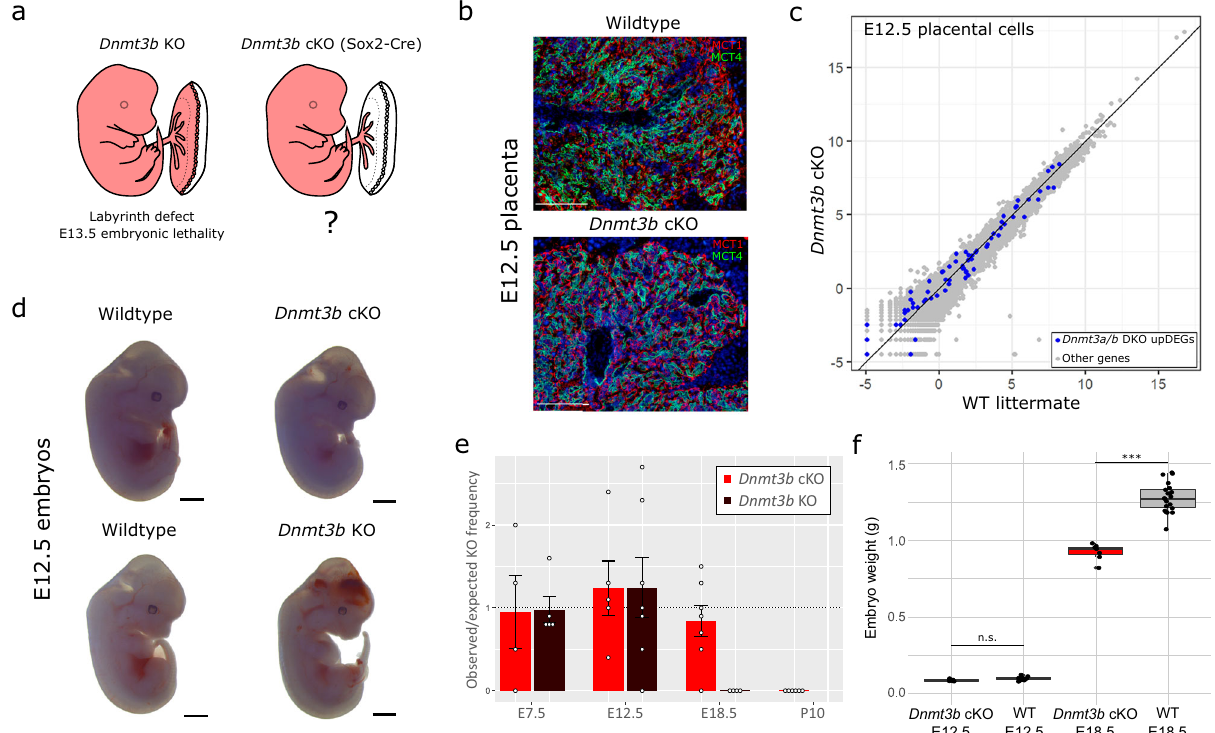
Fig. 5 | Dnmt3b cKOs show rescued placental labyrinth phenotype and conse- quently survive to birth. a The schematic diagram shows the lineages con- taining Dnmt3b deletioninthe Dnmt3b KOcomparedtothe Dnmt3b cKO,using Sox2-Cre. This schematic is adapted from Perez-Garcia, V. et al . Placentation defects are highly prevalent in embryonic lethal mouse mutants. Nature 555, 463-468 (2018). b Immuno fl uorescencefor MCT1(SynTI) and MCT4(SynTII)in E12.5placentasfroma Dnmt3b cKOandlittermateWTcontrol.Whitescalebar= 100 µ m. c The scatterplot shows gene expression, evaluated by single-nuclei RNA-sequencing in E12.5 placental cells, in Dnmt3b cKO, using Sox2-Cre, compared to WT littermate control. Cells were pseudo-bulked to generate log2(RPM) values for Dnmt3a/b DKO upregulated DEGs and other genes. d ImagesshowE12.5embryosfrom Dnmt3b KO, Dnmt3b cKOandlittermateWT